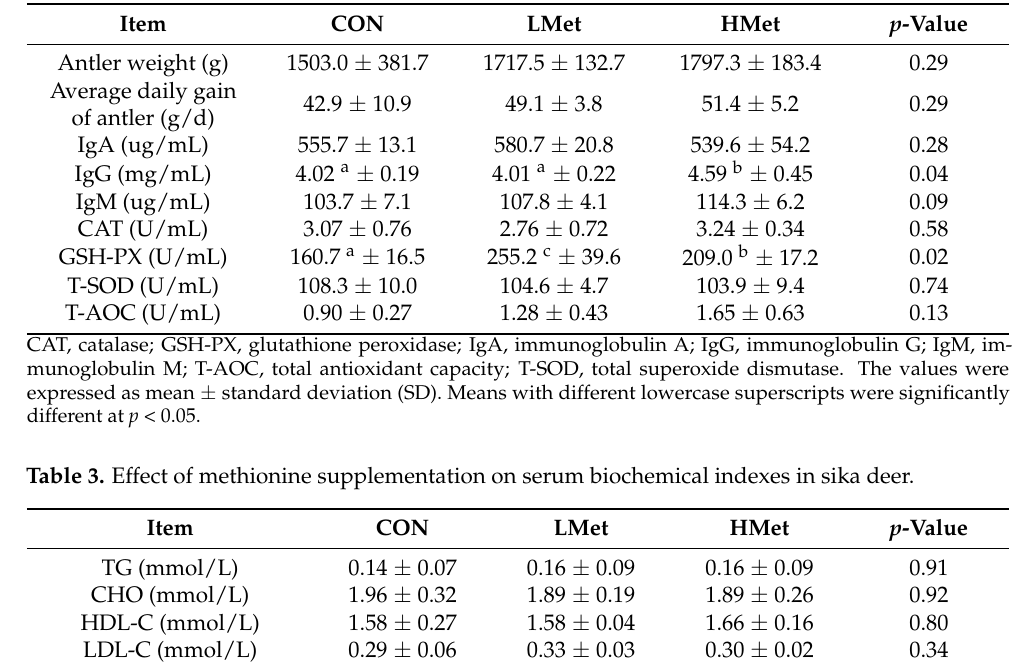
Table 2. Effect of methionine supplementation on productive performance and antioxidant and immune levels in sika deer.